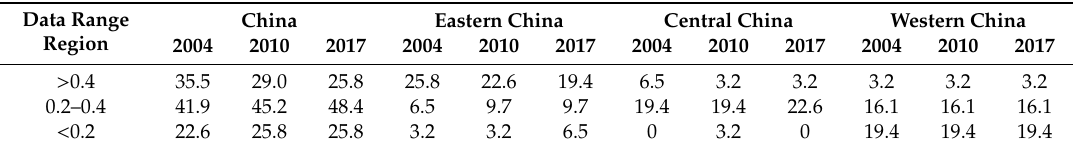
Table 3. Regional Spatial Distribution of HCR Concentration in 2004, 2010, and